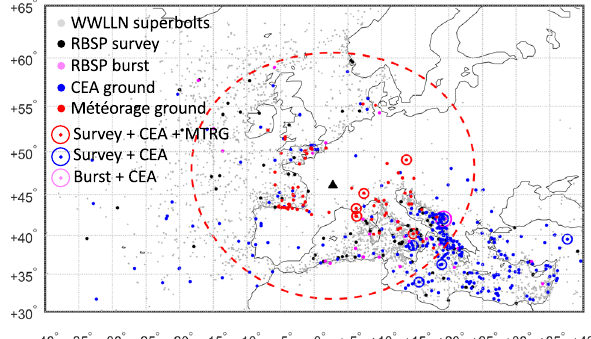
Fig. 1 Map of all European WWLLN-detected superbolts in 2012 – 2018. All European (gray circles) WWLLN-detected superbolts in 2012 – 2018, among which we highlight the superbolts measured by Van Allen Probes (RBSP) in (black circles) survey and (pink circles) burst modes. WWLLN superbolts seen in coincidence by (blue circles) ECLAIR and (red circles) both ECLAIR and Météorage ground measurements. (large pink circles) Synchronized observations from both space and ground with WWLLN, Van Allen Probes burst and ECLAIR. The red dashed circle de fi nes a 1500 km radius centered on the black triangle indicating the location of one of the ECLAIR stations used here. The x and y axes are longitude and latitude, respectively. The map itself is made with ©Matlab Mapping